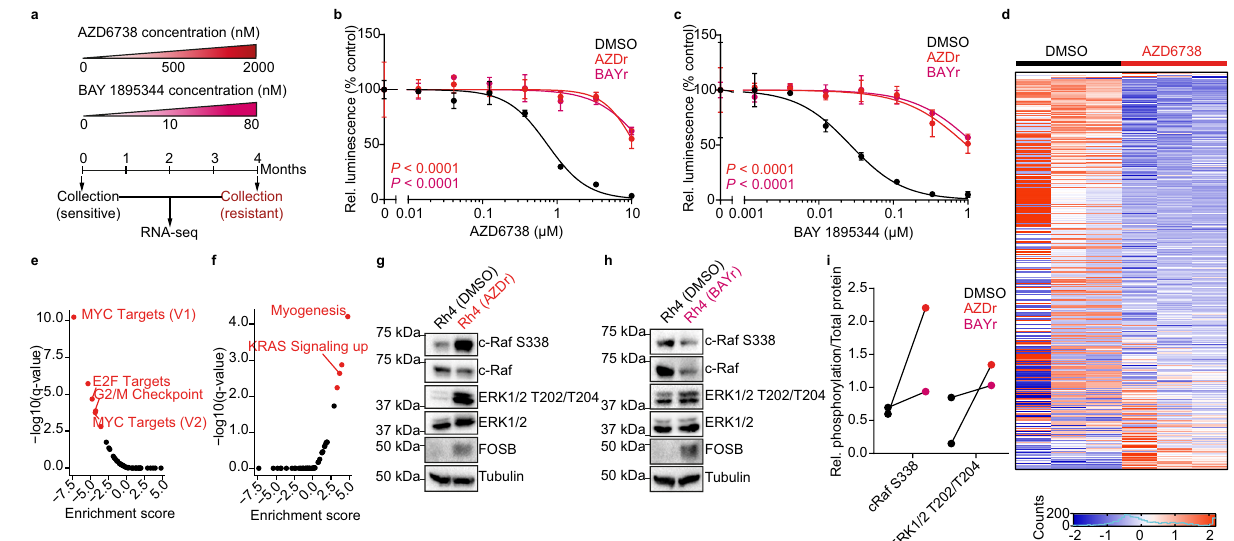
Fig. 6 | ATR inhibitor-resistant cells express FOSB and activated MAPK path- way. a Schematic representation of the generation of ATR inhibitor-resistant cells bylong-termexposuretoincreasingdosesoftheATRinhibitorsAZD6738andBAY 1895344. Dose-response curves of cell viability for resistant cells after incubation with AZD6738 ( b ) or BAY 1895344 ( c ) compared to treatment-naïve cells ( n =3 biologicallyindependent experiments). d Heatmapofthe 500 most variable genes based on RNA sequencing. Enrichment score for the GSEA hallmark pathways in